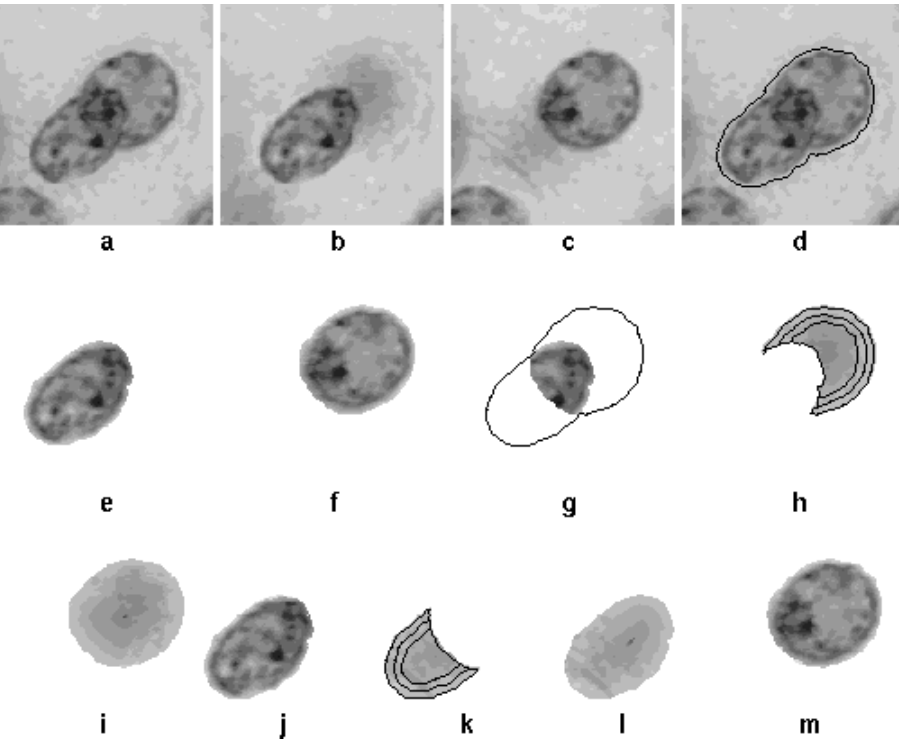
Fig. 1. Modifying density values in partial overlaps. (a) Compound image; (b), (c) two infocus sections for nuclei A, B chosen by the gradient method; (d) the region of interest, i.e., the union of the two nuclei; (e), (f) segmentation of the two nuclei in different focal planes; (g) intersection region of the two nuclei in which modification of the grey values is needed; (h), (i) reconstruction of the defocussed nucleus B; (j) cell A with OD component values from cell B in overlap region subtracted; (k), (l), (m) repeat of this process on cell